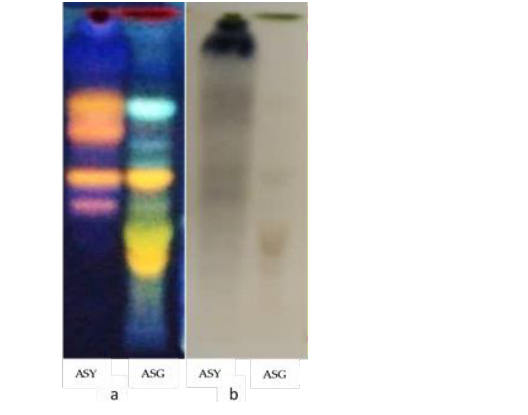
Figure 1. ( a ) Presence of flavonoids sprayed by Neu’s reagent at UV 365 nm (orange, yellow and